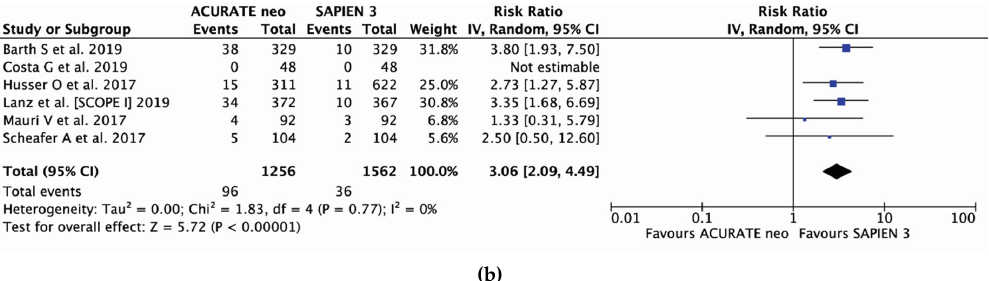
Figure 4. Individual and summary risk ratios with corresponding 95% confidence intervals for the comparison of ACURATE neo vs. SAPIEN 3 in the analysis of functional outcomes: ( a ) mild and ( b ) moderate-to-severe paravalvular leak.